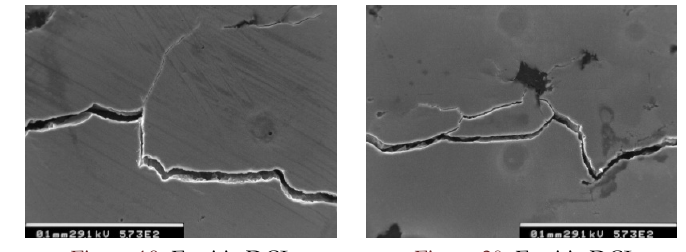
Figure 20: Ferritic DCI (R = 0.5,  K = 18 MPa √ m).